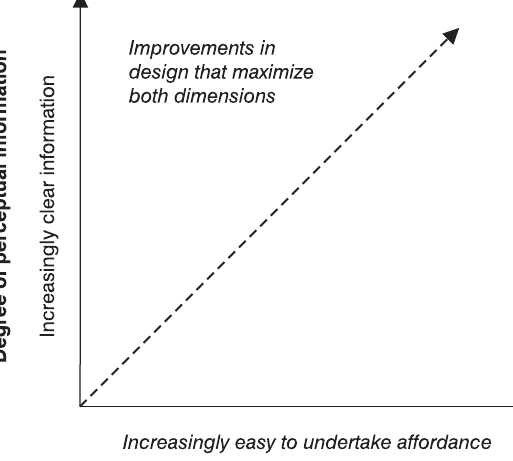
Figure 1. McGrenere and Ho’s diagram representing the affordance and the information that specifies the affordance as a